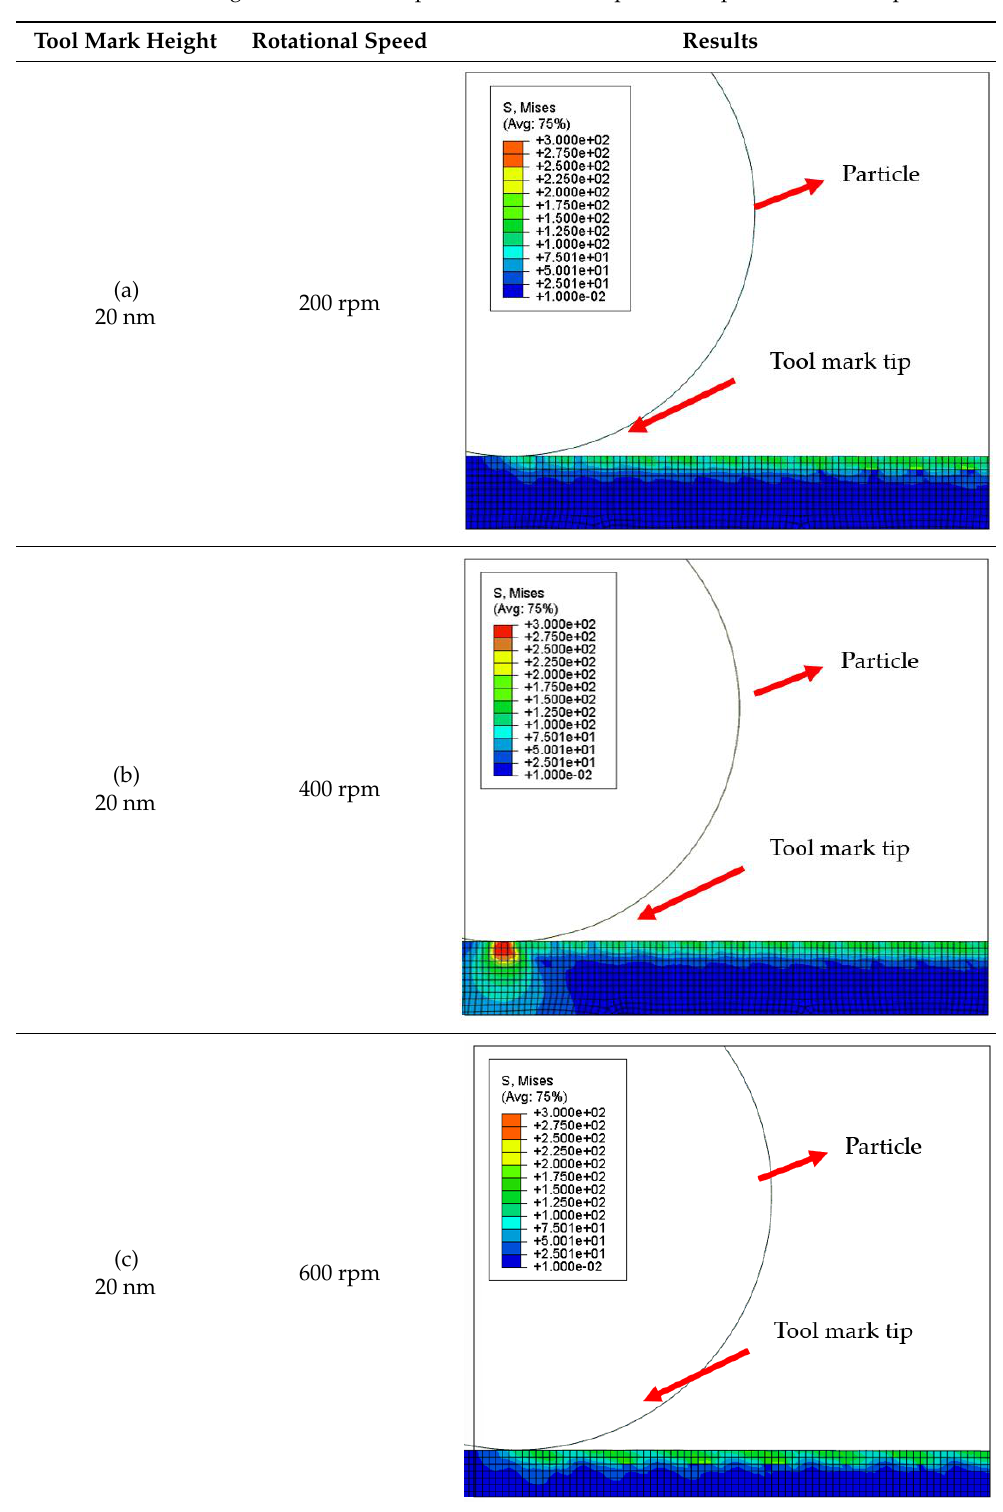
Table 5. The 20 nm high tool mark workpiece surface under particle impact at different speeds.